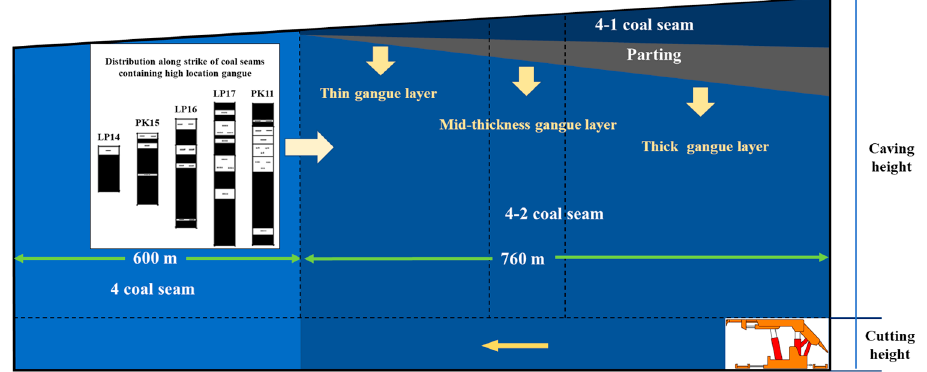
Figure 1. Working face 42,108 coal seam along the strike profile.